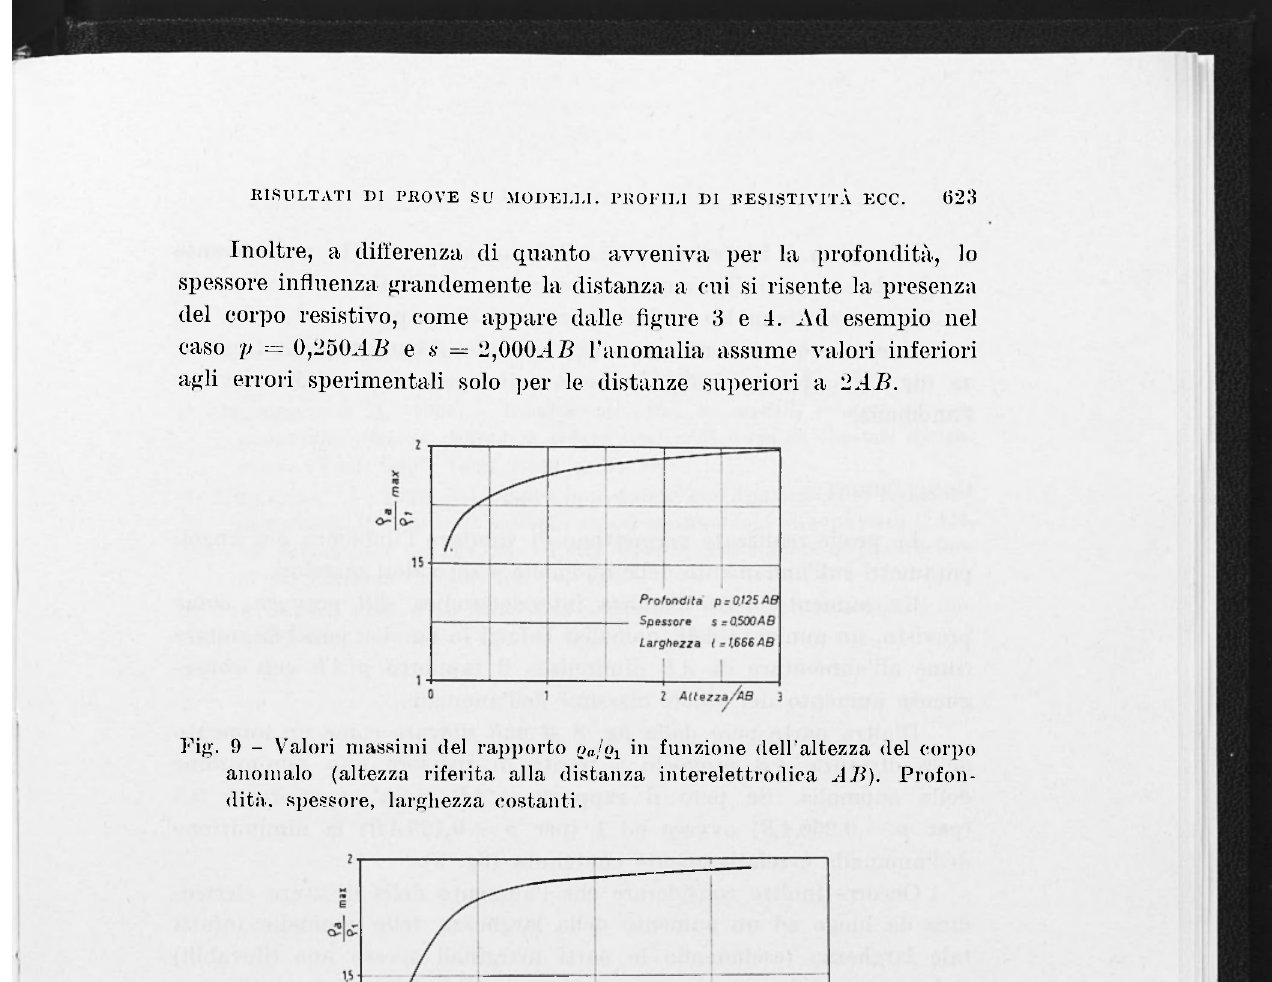
Fig. 9 - Valori massimi del rapporto Qa/ei in funzione dell'altezza del corpo anomalo (altezza riferita alla distanza interelettrodica AB). Profon-